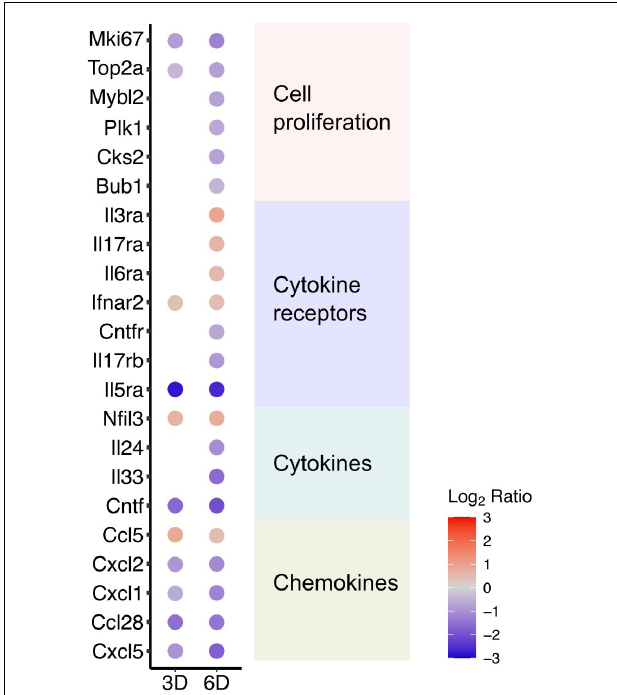
FIGURE 4 | DOX-responsive cytokines and cell proliferation markers. Significantly changed genes encoding cytokines including chemokines were identified and listed in the plot. In addition, expressional changes of genes previously known as cell proliferation markers were listed in the